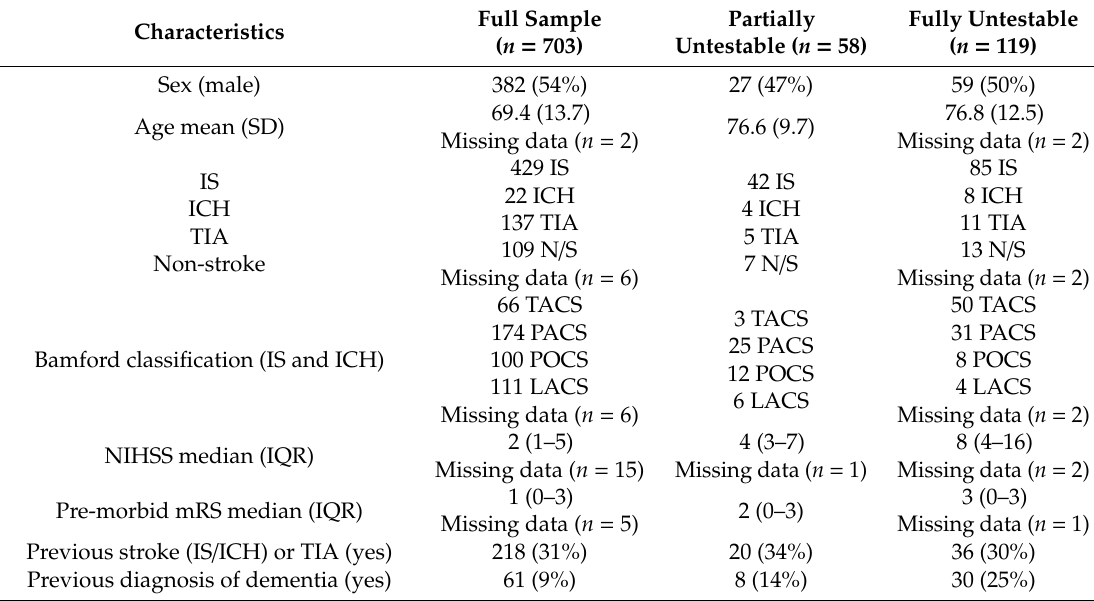
Table 3. Characteristics of the